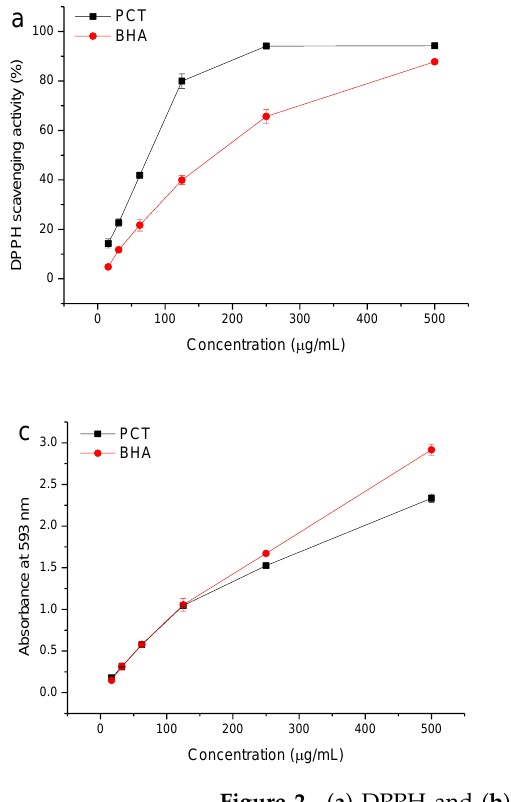
Figure 2. ( a ) DPPH and ( b ) ABTS free radical scavenging activities of different concentrations of tannins extracted from plum pericarp. ( c ) Ferric reducing power of different concentrations of tannins extracted from plum pericarp. PCT, condensed tannins of plum pericarp; BHA, butylated hydroxyanisole.